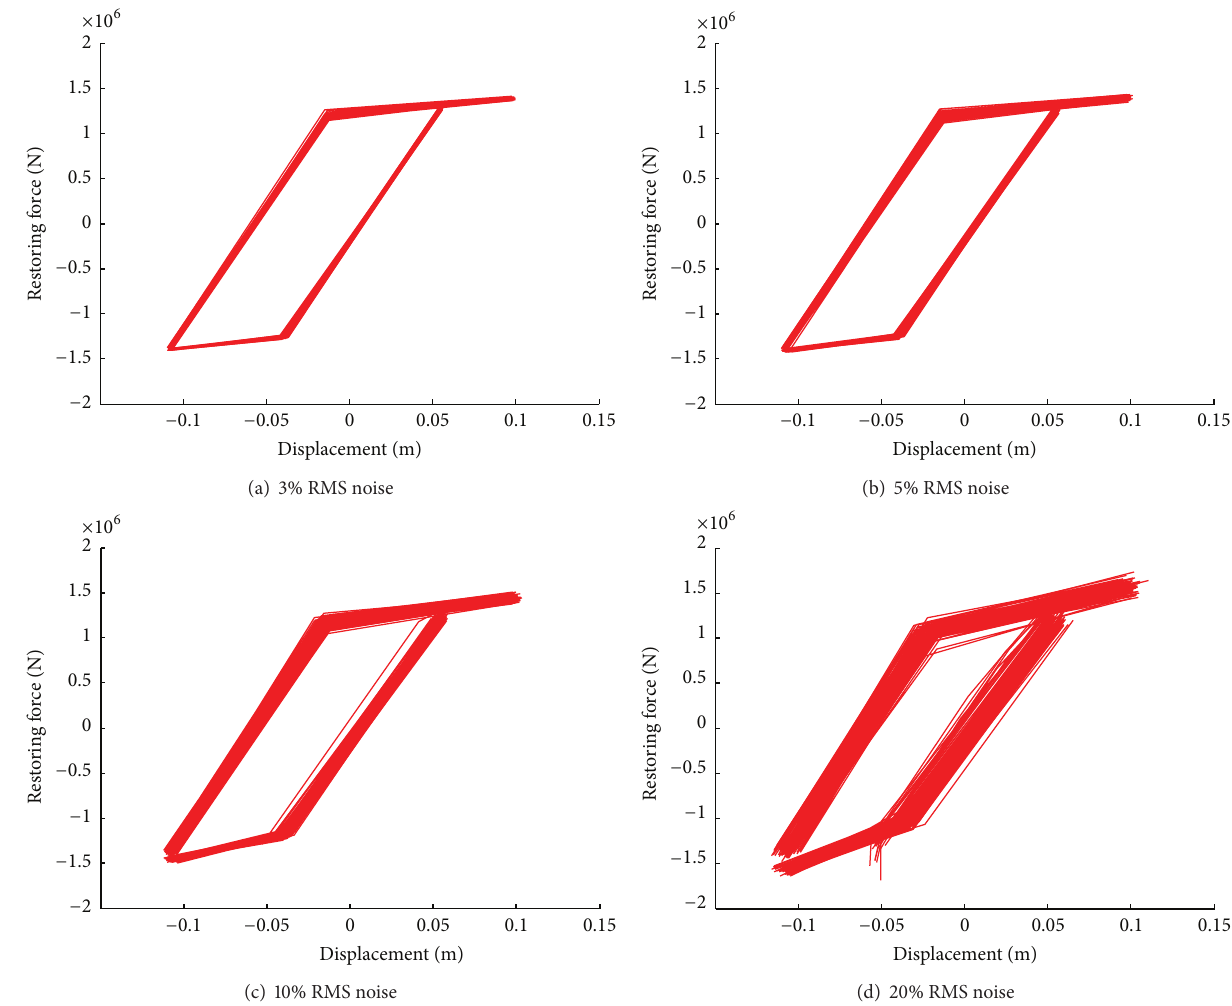
Figure 6: Identified nonlinear half cycles and multiphase linear regression